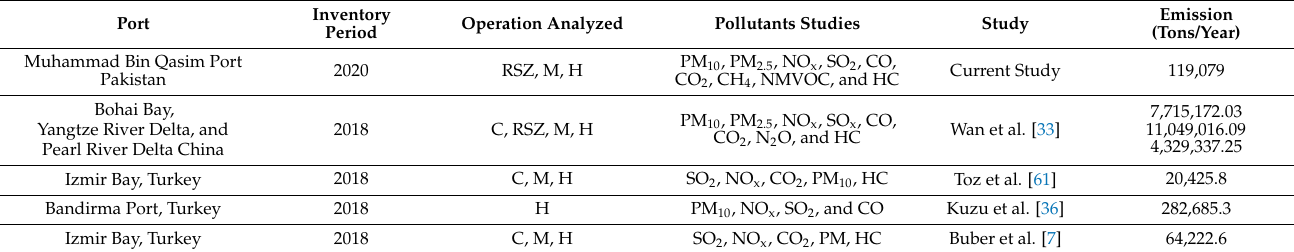
Table 5. Comparison with previous emission inventories